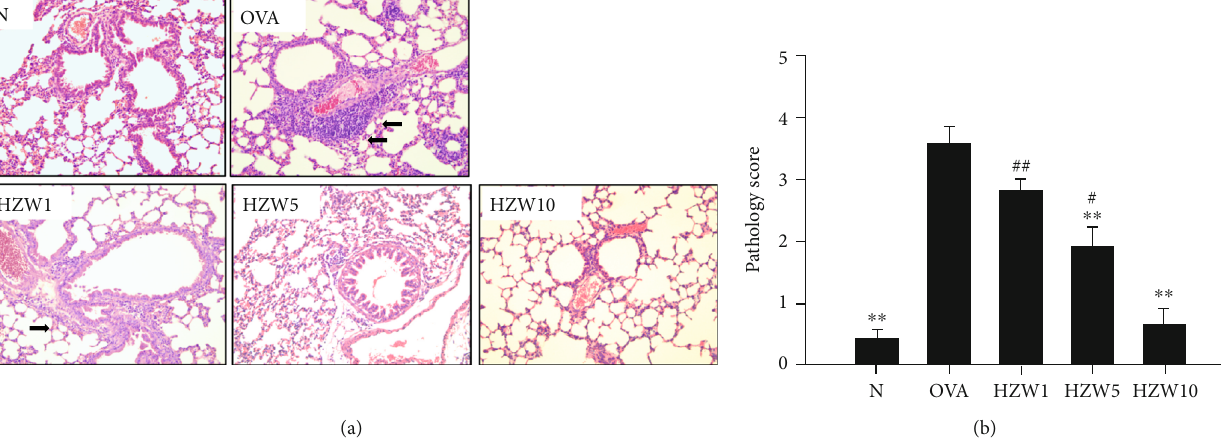
Figure 6: The e ff ect of HZW on eosinophil in fi ltration of lung tissue in OVA-sensitized mice. (a) Hematoxylin and eosin staining of lung sections (6 μ m) observed eosinophil in fi ltration (200x magni fi cation). Eosinophils were indicated with arrows. (b) The scoring of in fl ammation via pathological evaluation in lung sections. Data are presented as the mean ± SEM . ∗ P < 0 : 05 and ∗∗ P < 0 : 01 compared with the OVA control group. # P < 0 : 05 and ## P < 0 : 01 compared to the HZW10 group.